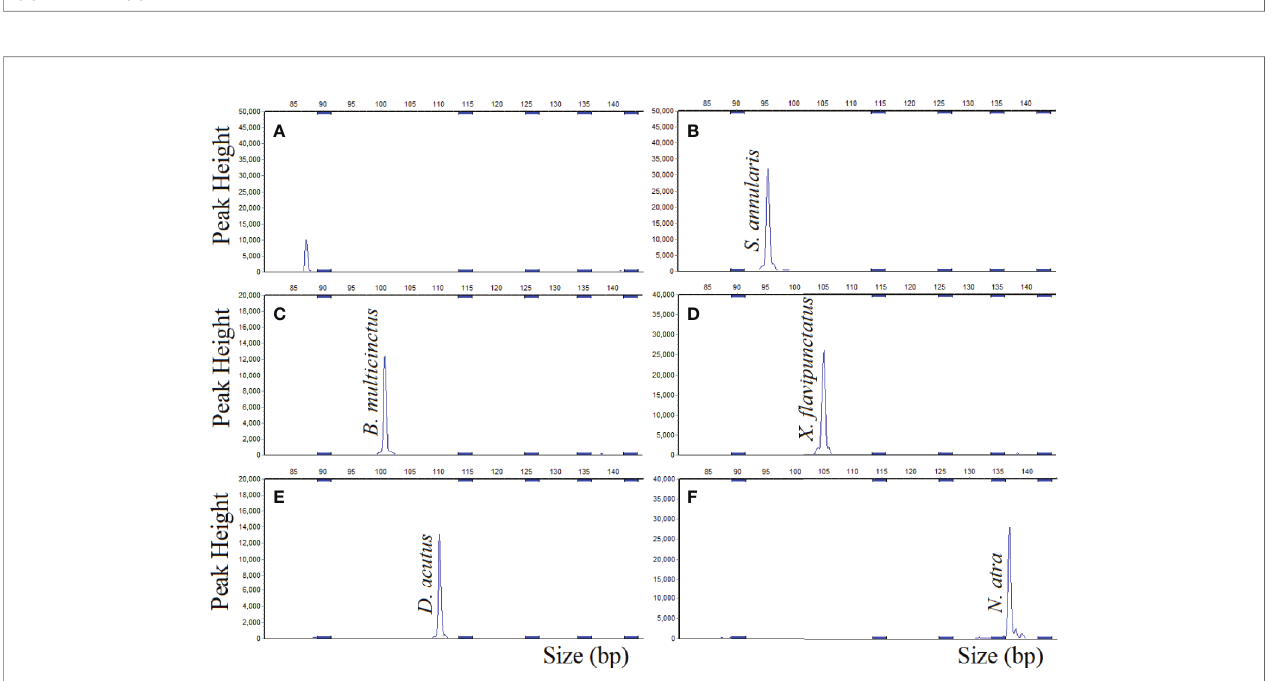
FIGURE 3 | MLPA probemix speci fi city, DNA sample hybridized with probemix. (A) negative control; (B) S. annularis ; (C) B. multicinctus ; (D) X. fl avipunctatus ; (E) D. acutus ; (F) N. atra